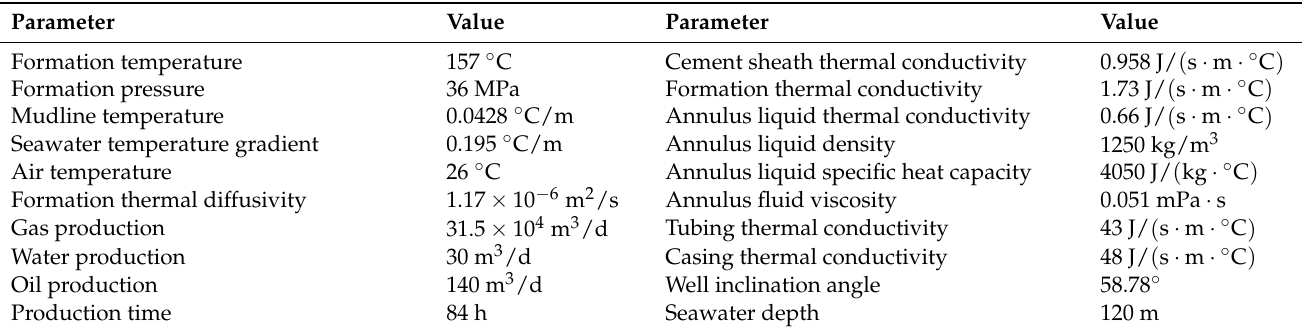
Table 1. Basic parameters of case